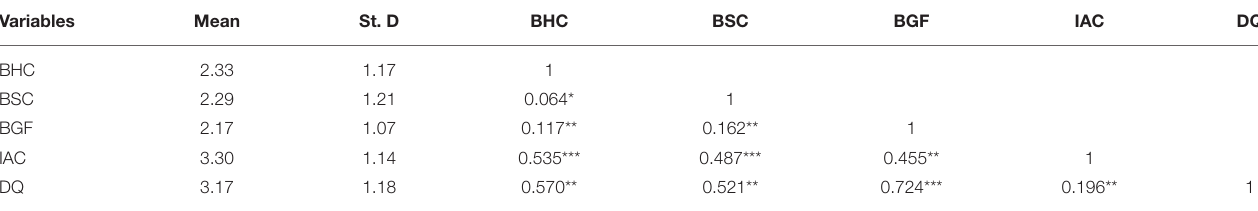
TABLE 3 | Means, standard deviations, and correlation coefficients among variables.